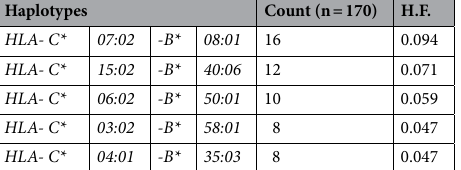
Table 3. Five most frequent HLA-C-B two-locus haplotype counts observed in the UAE cohort. H.F.: haplotypes frequency.